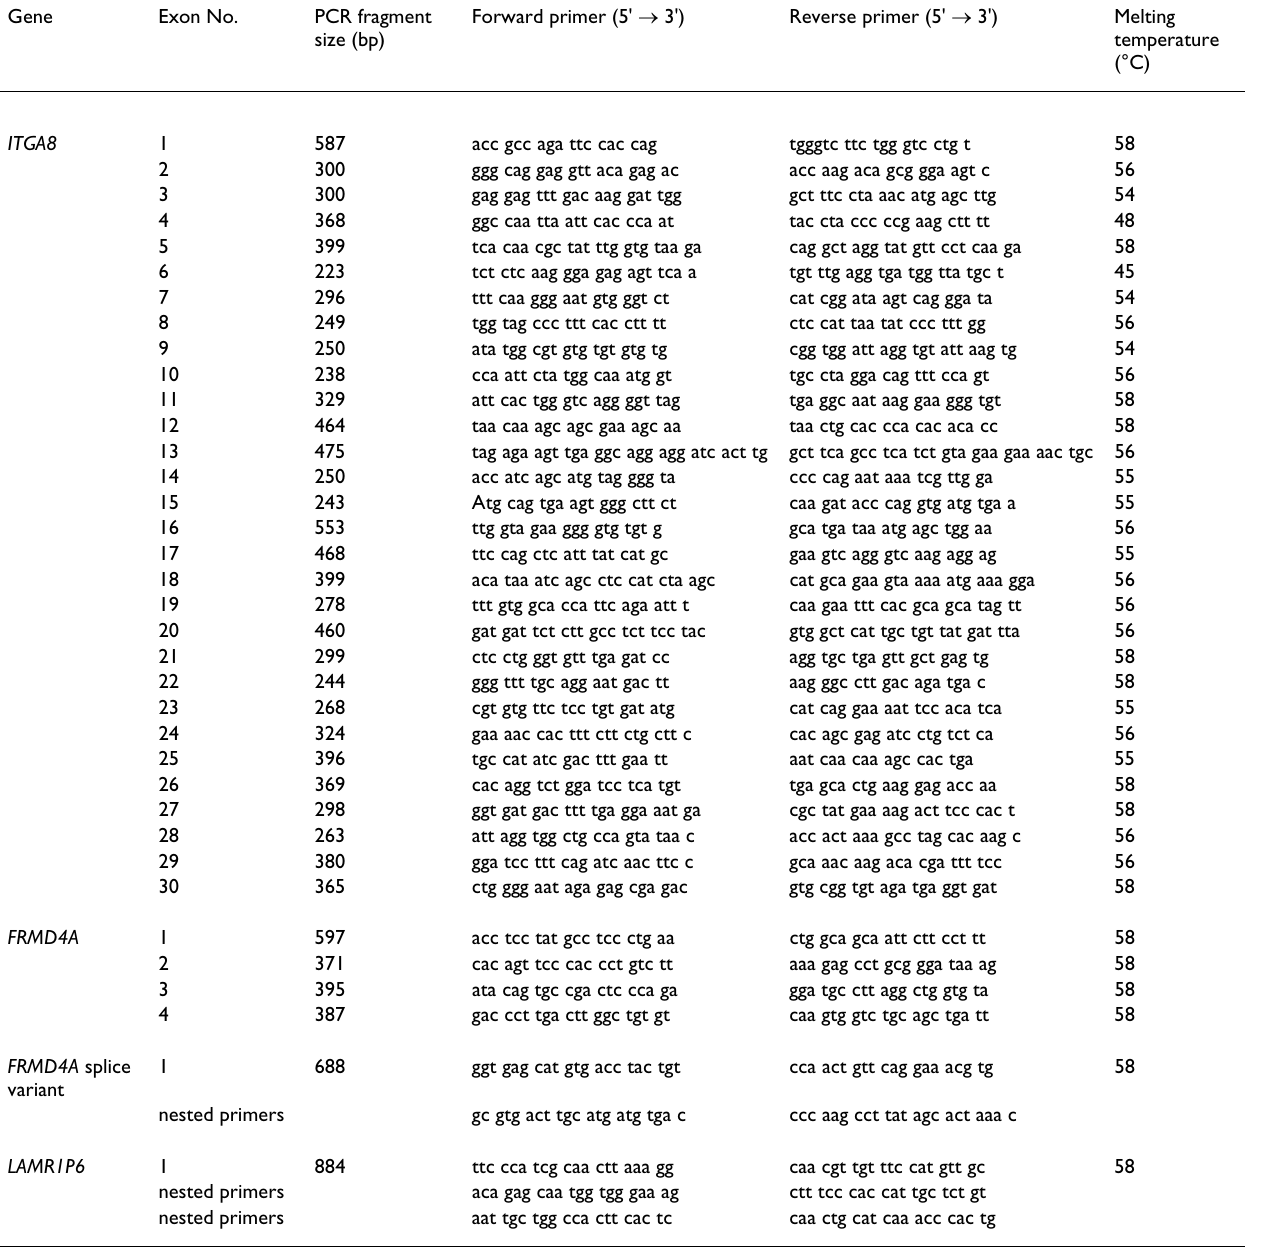
Table 1: Oligonucleotide primers used for PCR amplification and DNA sequencing of the exons of the ITGA8, FRMD4A, and LAMR1P6 genes. Gene Exon